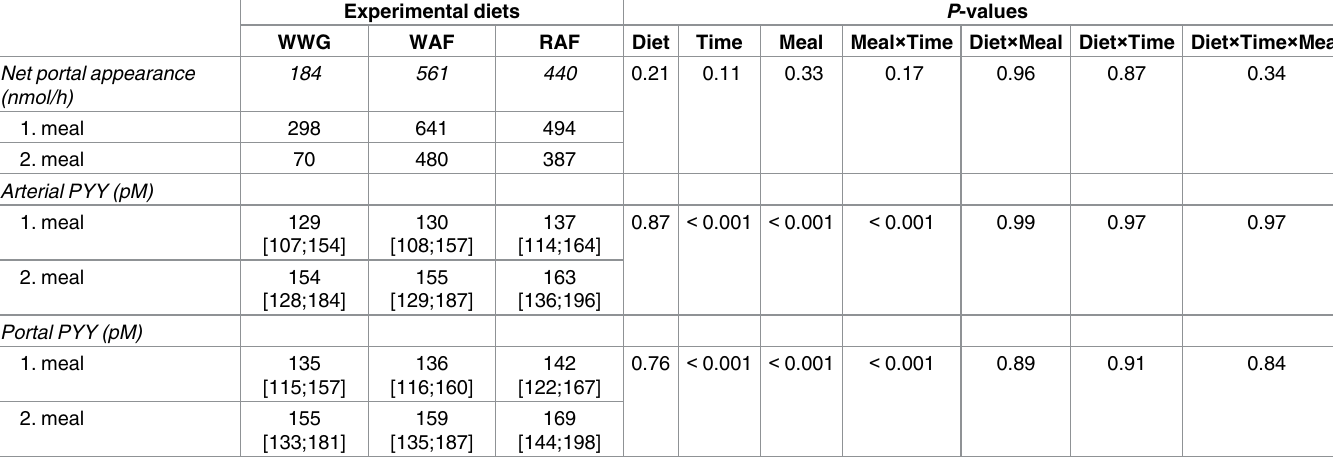
Table 3. Postprandial net portal appearance of PYY and PYY concentrations in the mesenteric arteryand portal vein of pigs fed of pigs fed WWG, WAF, and RAF 1 .